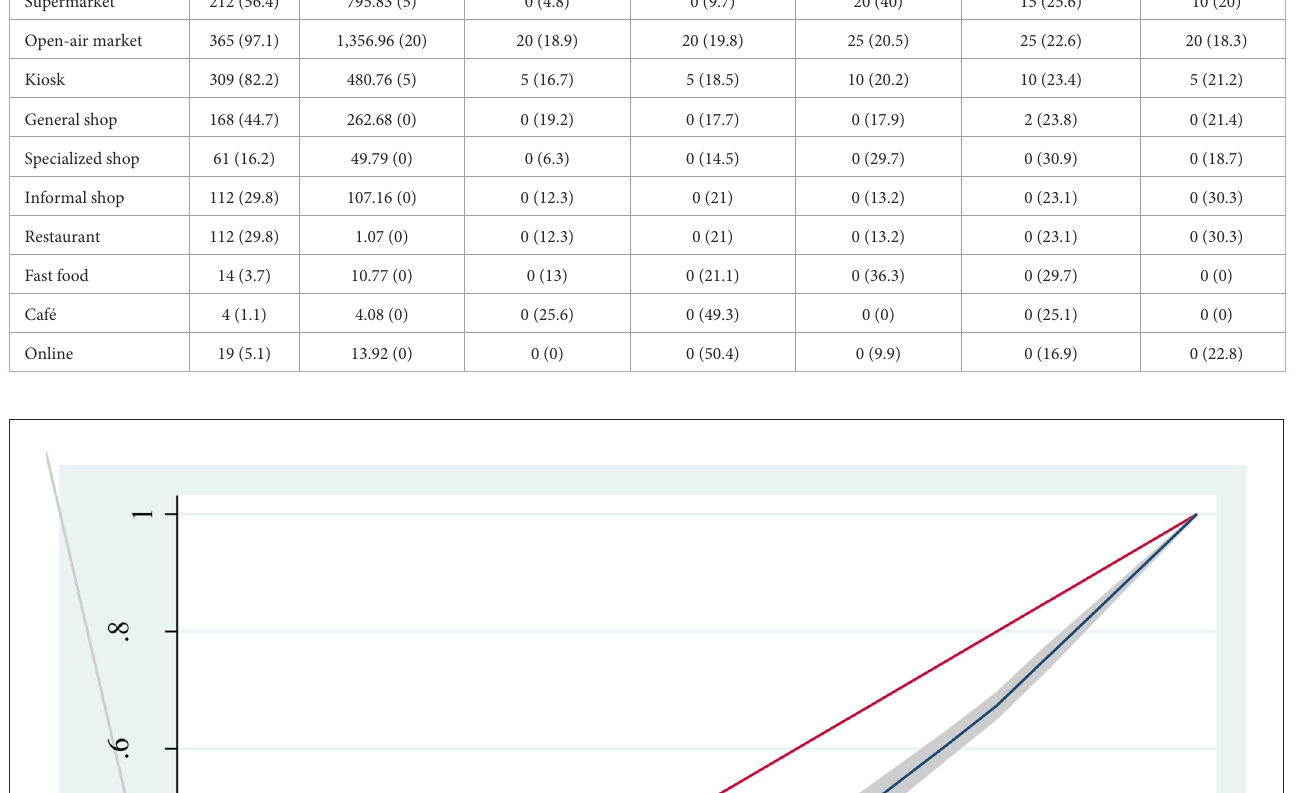
(raised blood pressure, overweight/obesity, raised blood glucose, and raised cholesterol) (32). Our study has established that there exist socioeconomic inequalities in the consumption, purchasing